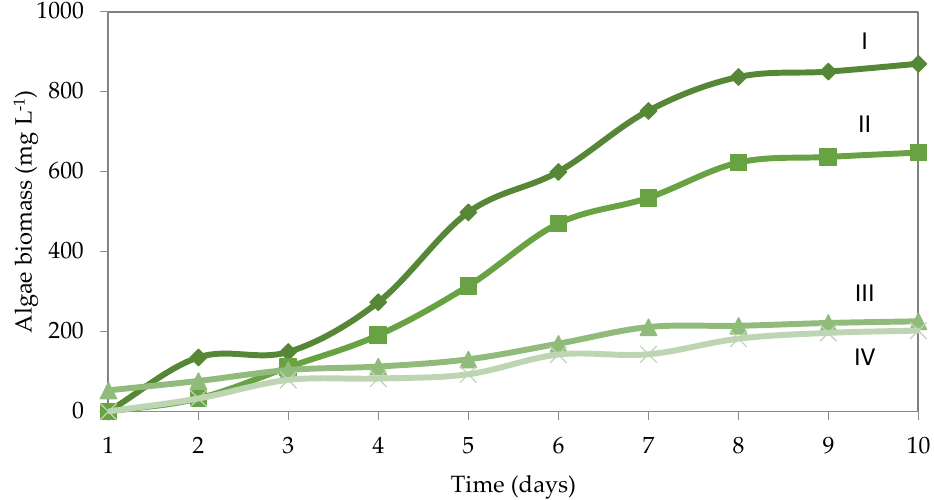
Figure2. GrowthofalgaebiomassasafunctionoftimeforGuillardmedium—I;AMDafterconventional Figure 2. Growth of algae biomass as a function of time for Guillard medium — I; AMD after conventional treatment with nutrients — II; AMD after conventional treatment without nutrients — III; treatment with nutrients—II; AMD after conventional treatment without nutrients—III; and for the and for the control (water purified by reverse osmosis) — IV. control (water purified by reverse